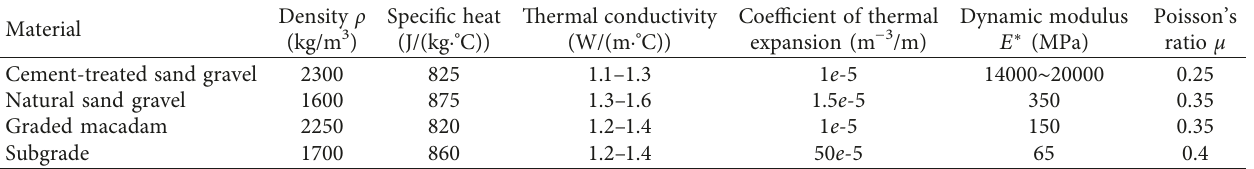
Table 6: Thermophysical and mechanical parameters of chemical-treated and other pavement